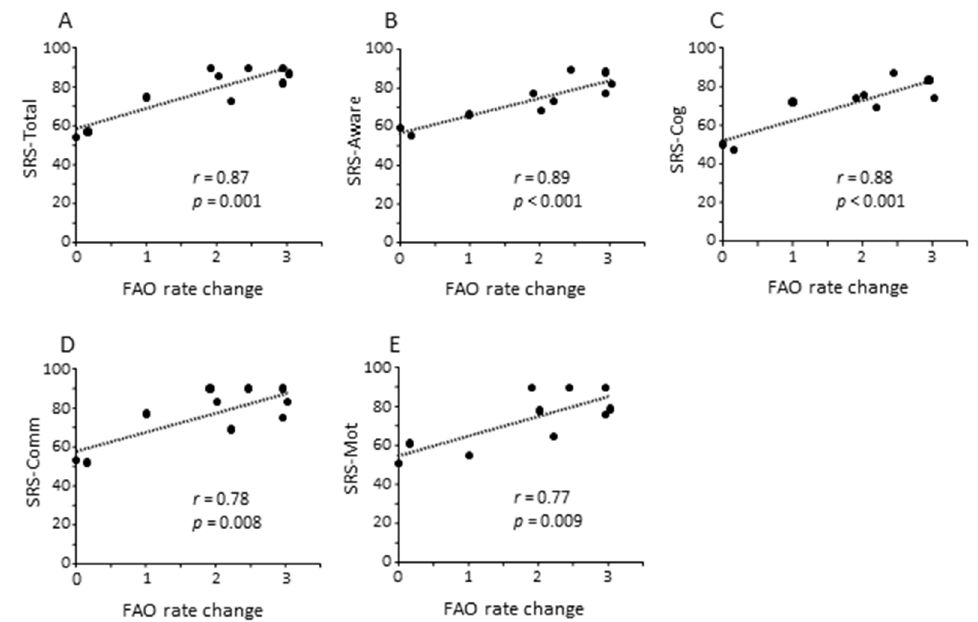
Figure 4. Correlation analyses among clinical characteristics of patients with ASD as measured by the Social Responsiveness Scale (SRS) and resveratrol (RSV) effect on fatty acid oxidation (FAO) in fibroblasts. Highest changes of mtFAO in response to RSV were significantly associated with clinical impairment (higher scores) on the SRS–total ( A ) as well as on SRS awareness ( B ), cognition ( C ), communication ( D ), and motivation ( E ) subscales.